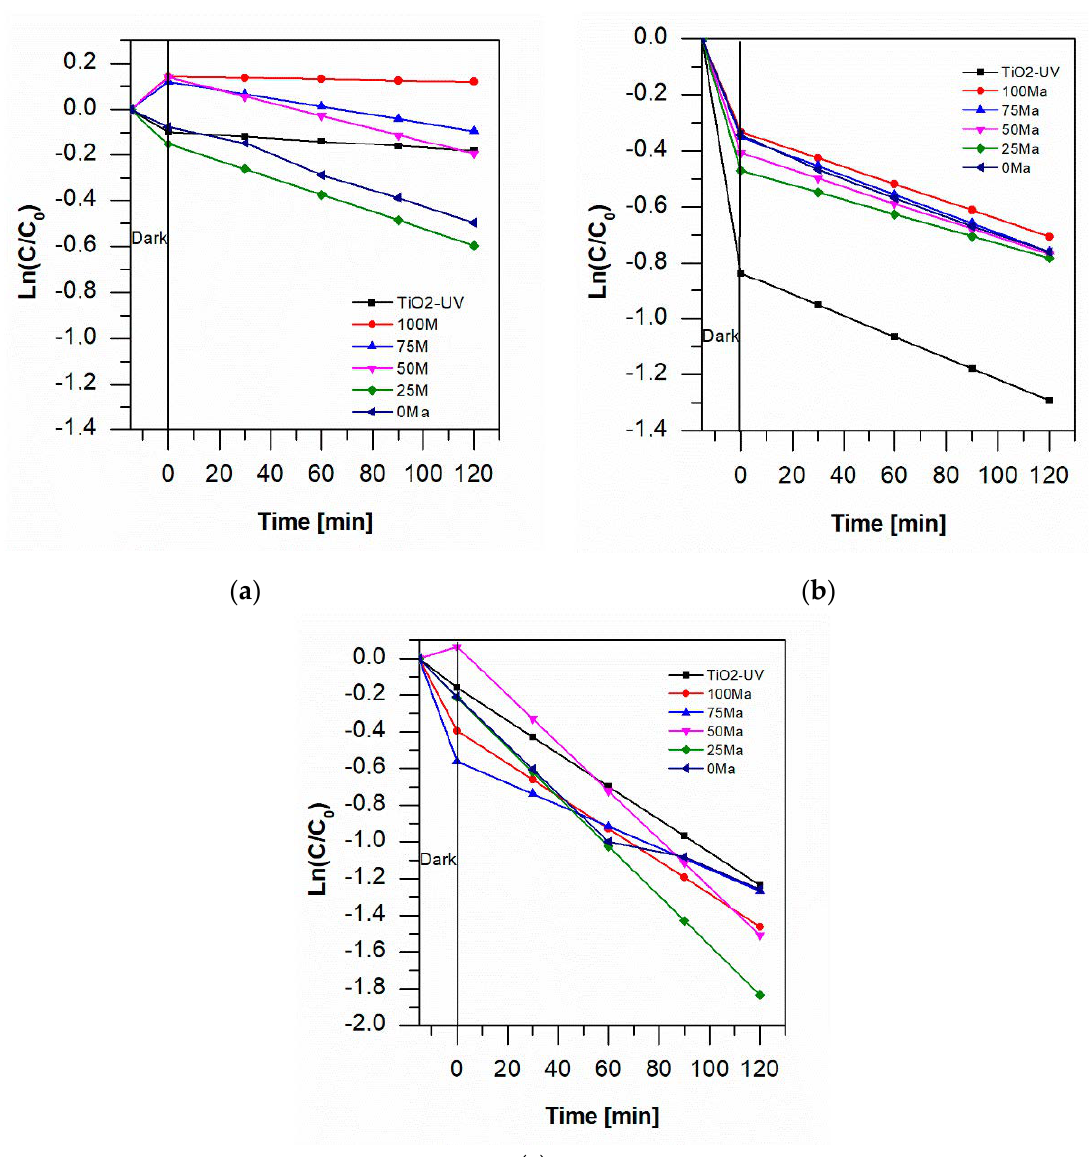
Figure 7. Kinetic behavior of aniline degradation at ( a ) pH 7, ( b ) pH 3 and ( c ) pH 3 + O 2 . Table 2. Langmuir-Hinshelwood rate values for aniline blue degradation by the photocatalytic process with TiO 2 -foam/UV light and TiO 2 -anthocyanin-foam/visible light.